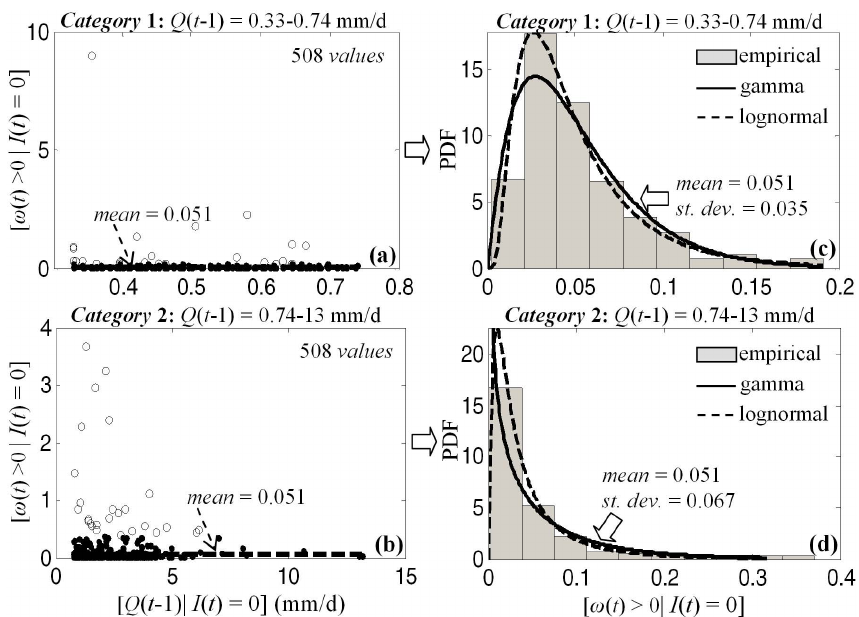
Fig. 4. Same as Fig. 3 but using daily rainfall intensities from the location of the dam (point B in Fig. 2) for the period 1 October 1974– 30 September 1993 (i.e. 19yr, 1016